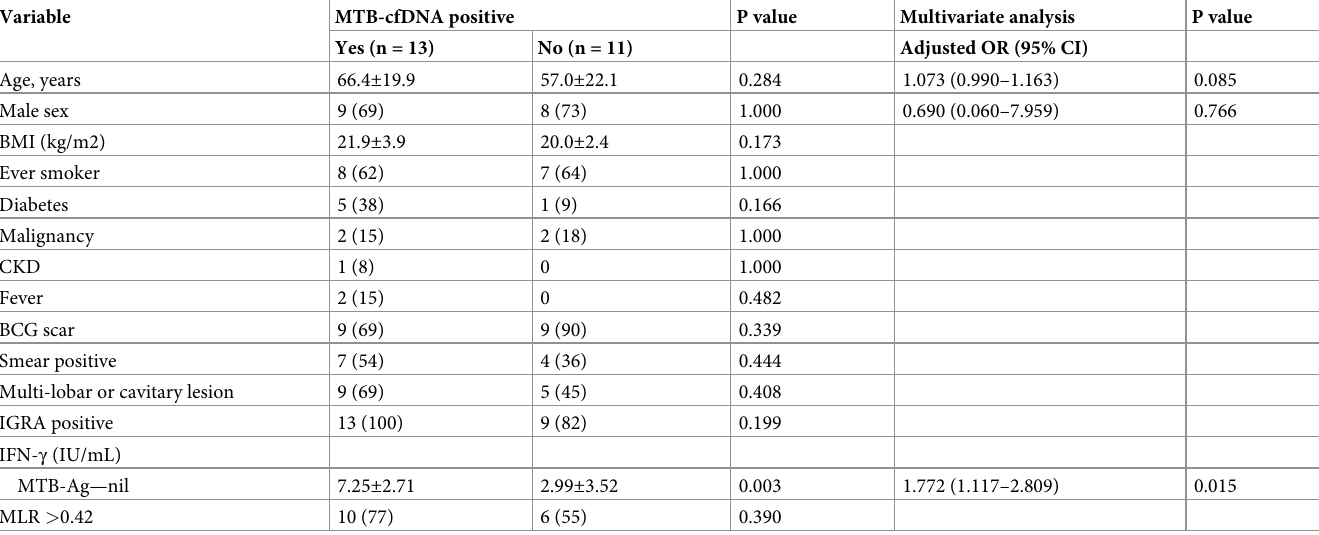
Abbreviations: BCG, Bacillus Calmette–Gue´rin vaccine; BMI, body mass index; cfDNA, cell-free DNA; CKD, chronic kidney disease; IFN- γ , interferon-gamma;